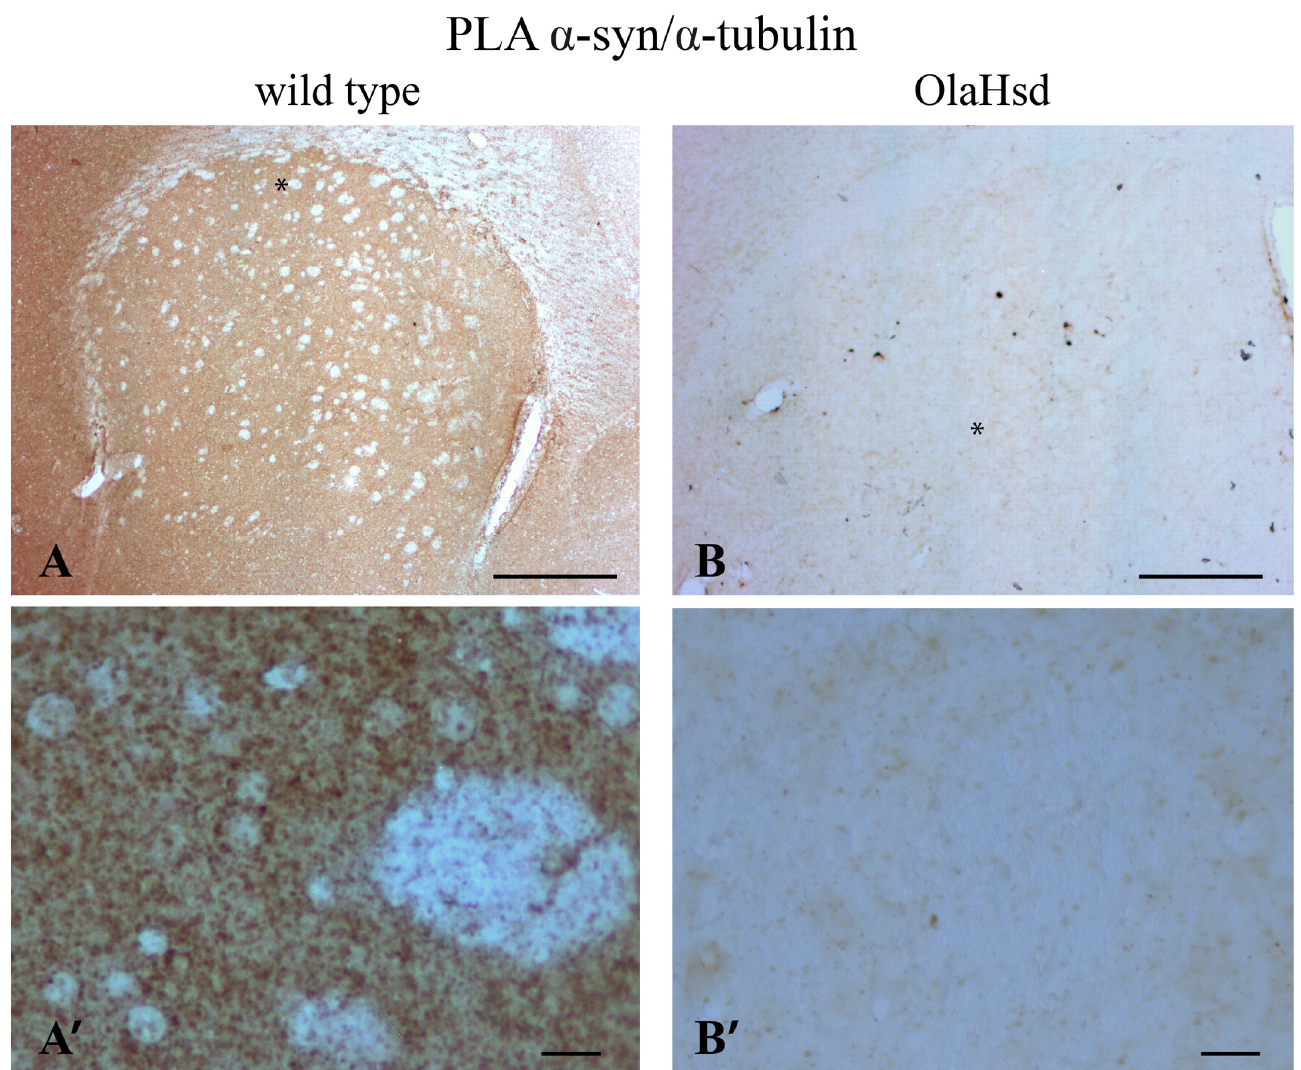
Figure 4. Brightfield PLA procedure for α -synuclein/ α -tubulin PLA in corpus striatum of wild type and OlaHsd mice. ( A , B ): Low magnification image of PLA staining (brown) for α -synuclein/ α -tubulin PLA in wild type mouse brain corpus striatum (( A ), n = 4 mice) compared to the almost negative signal in OlaHsd mouse (( B ), n = 4 mice). In ( A ), white dots are the typical bundles of fibers in the striatum that are negative for the PLA staining. ( A’ , B’ ): High magnification photomicrographs of the striatum . Asterisks in ( A , B ) indicate the regions that are magnified in ( A’ , B’ ), respectively. Scale bars: 500 µ m ( A,B ), 10 µ m ( A’ , B’